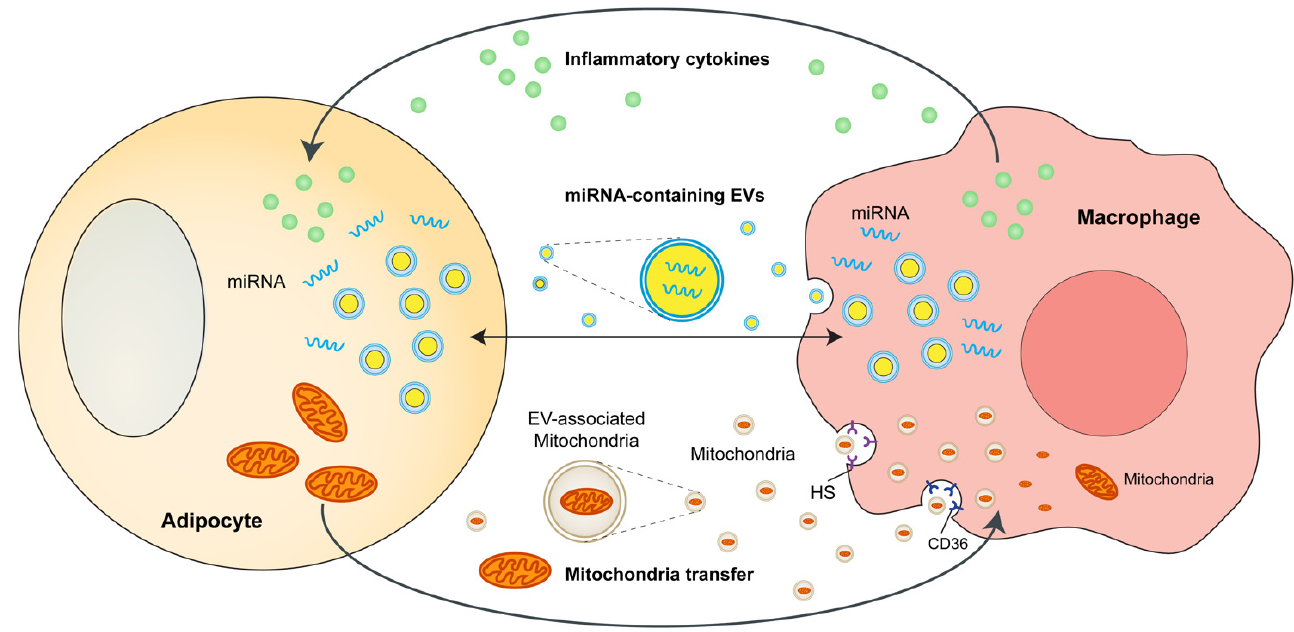
Figure 1. Interactions between adipocytes and ATMs in obesity. Adipocytes and macrophages interact with each other through a variety of mechanisms, including cytokine and chemokines, microRNA-containing exosomes or microvesicles, and mitochondrial transfer. ATMs, adipose tissue macrophages; miRNA, microRNA; EVs, extracellular vesicles; HS, heparan sulfates.